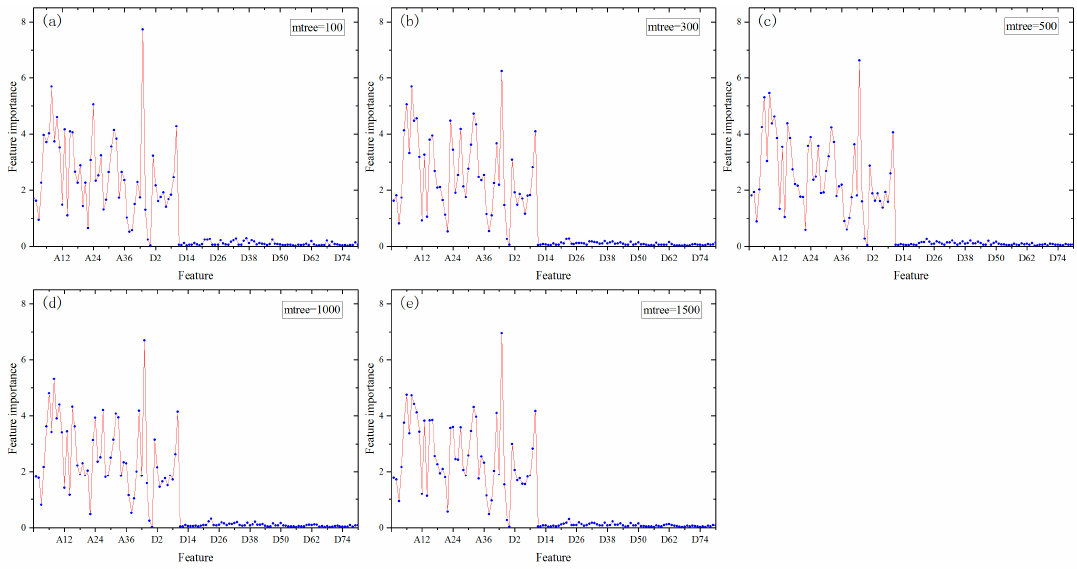
Figure 3. Feature importance. A total of 15 parameter combinations were tested and only five ( ntry = 11) are shown in the graph for illustration.